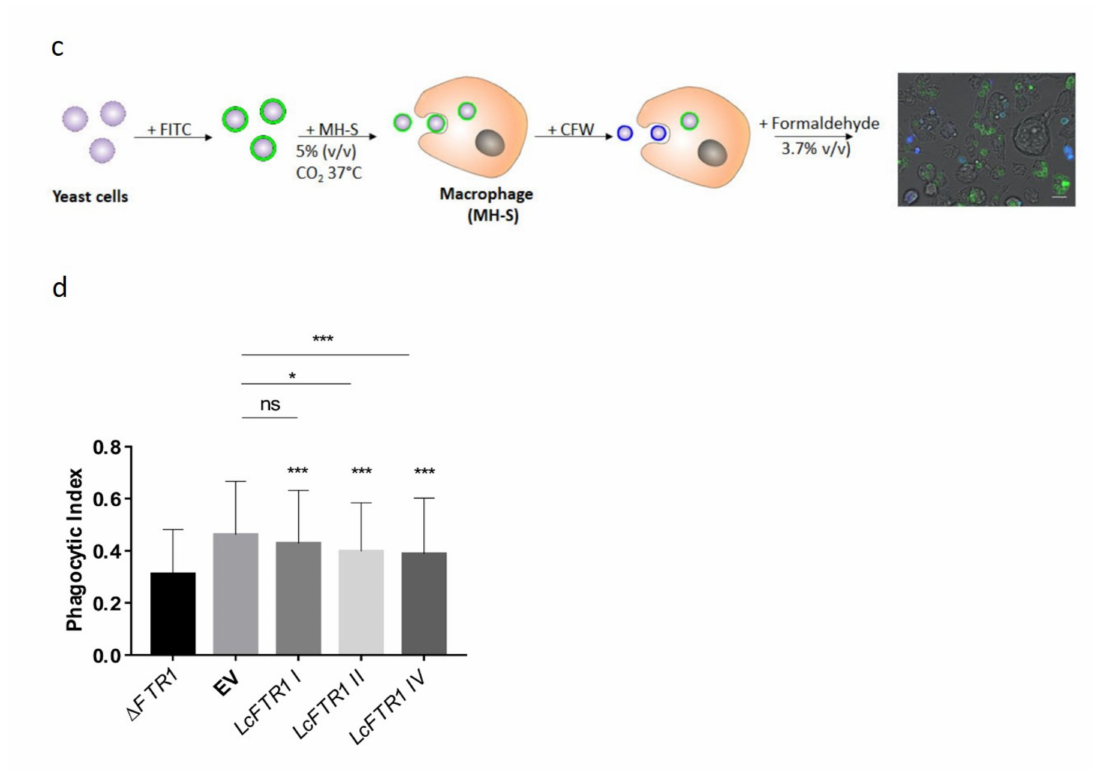
Figure 7. Restoration of iron-dependent growth defect in S. cerevisiae ∆ FTR1 mutants by the three copies of the LcFTR1 genes. ∆ FTR1 S. cerevisiae strains were transformed with a vector expressing LcFTR1 I, II and IV under the control of Tet or vector alone and assessed for iron consumption. ( a ) Control conditions with 50 µ M FeCl 3 ; ( b ) high iron using 350 µ M FeCl 3 . Error bars indicate standard deviation of the triplicate measurements; significant differences between the induced and uninduced samples determined by unpaired Student’s two-tailed t-test are indicated by * ( α = 0.002) or ** ( α = 0.001). ( c ) Schematic showing the workflow used to for interaction of murine alveolar macrophages (MH-S) with heterologous yeast strains and data output. ( d ) Interaction of murine alveolar macrophages (MH-S) with iron-dependent growth defect of S. cerevisiae FTR1 null mutants complemented with the 3 copies of L. corymbifera LcFTR1 genes. S. cerevisiae FTR1 null mutants overexpressing FTR1 genes (I, II and IV) were phagocytosed by MH-S. The statistical test was performed based on comparison of over-expressing FTR1 gene of L. corymbifera to S. cerevisiae expressing empty vector (EV) for vector control without insert. Student’s t -test was used to determine the significant difference, as ns denotes non-significant difference, * means p < 0.05, ** means p < 0.01 and *** refers to p <